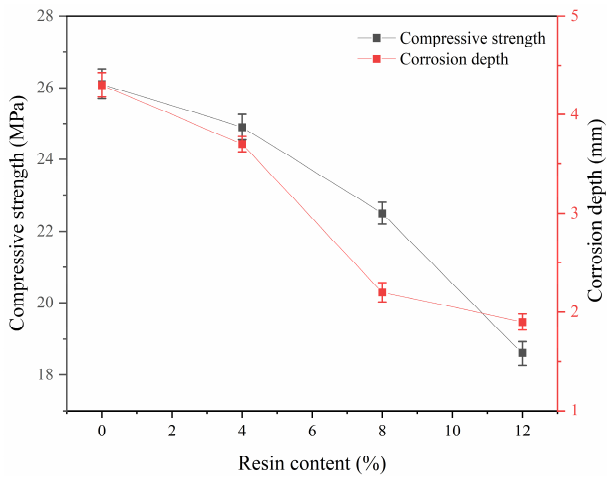
Figure 6. E ff ect of slag on cement slurry performance. Figure 7. E ff ect of polymer resin on cement slurry performance. Figure 7. Effect of polymer resin on cement slurry